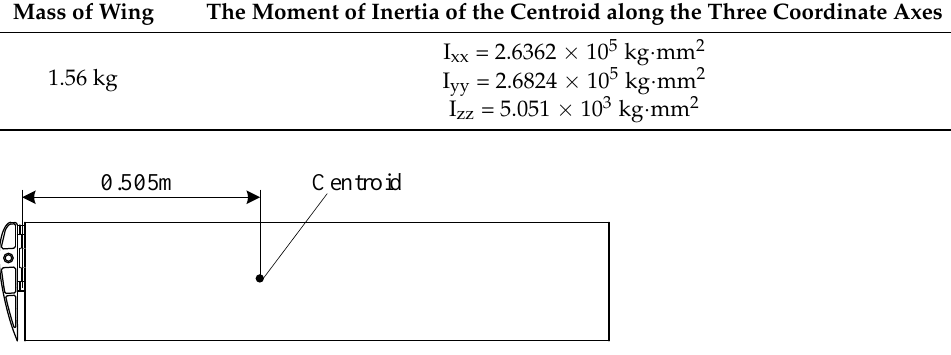
Figure 8. Diagram of wing centroid position.